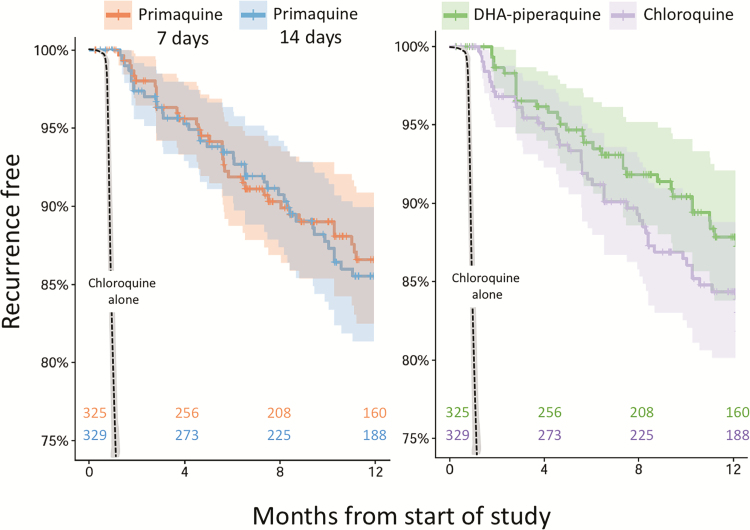
Recurrence of Plasmodium vivax malaria during the 1-year study. Survival curves comparing marginal time to first recurrence in the 2 schizontocide groups (left panel) and the 2 radical cure groups (right panel). Vertical notches denote right censored observations. 95% confidence intervals are shown by the shaded areas. The dashed black line shows the proportion recurring when not given radical cure in recent (two years previous) historical controls from the same study site [22].